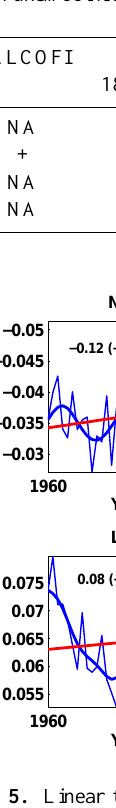
Fig. 4. Linear trends (red line) of meridional wind stress from the NCEP/NCAR reanalysis dataset (Kalnay et al., 1996) calculated by the method of least squares. NW Africa and Peru show a decrease of upwelling. There is an increase of upwelling in L¨uderitz and an insignificant trend in California. In the Northern Hemisphere a neg- ative slope indicates increase of upwelling. The value of the slope and its 95% confidence interval are given in each panel (in units of 10 − 3 Nm − 2 yr − 1 ). A ∗ indicates that the slope is statistically significant at the 0.05 level. Also shown are the unsmoothed time series (thin lines).